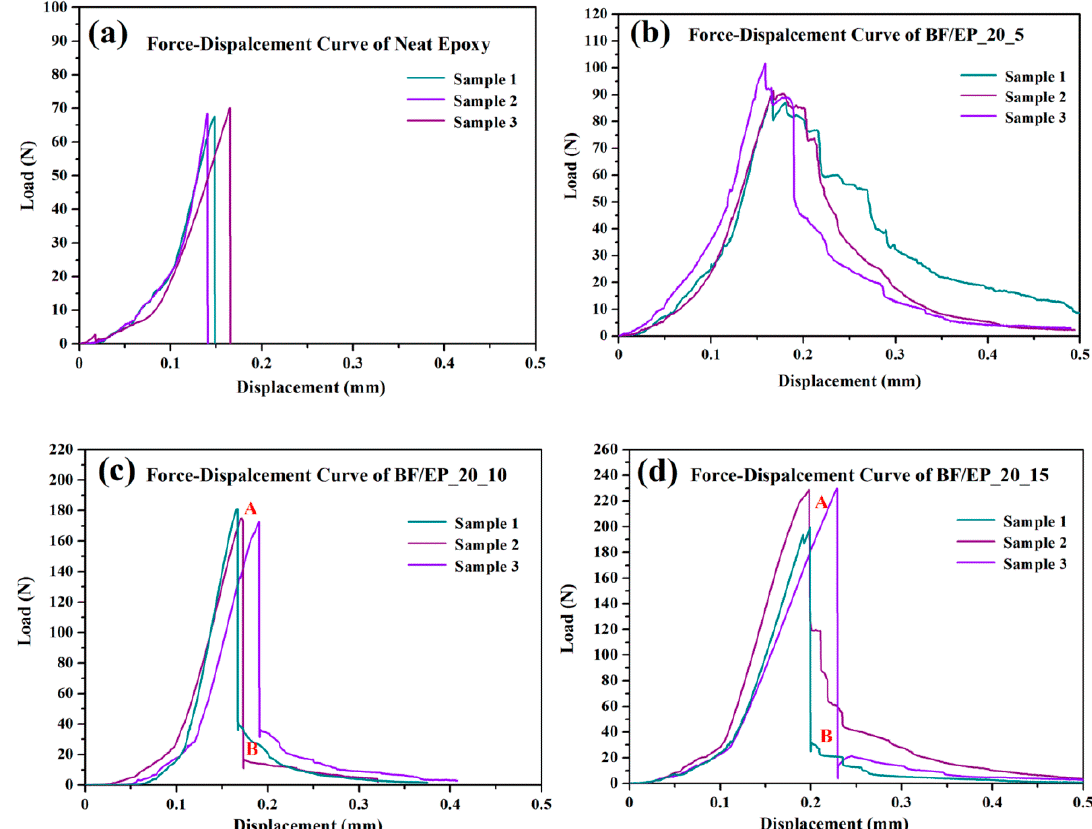
Figure 15. Force-displacement curves of bamboo fiber composites.